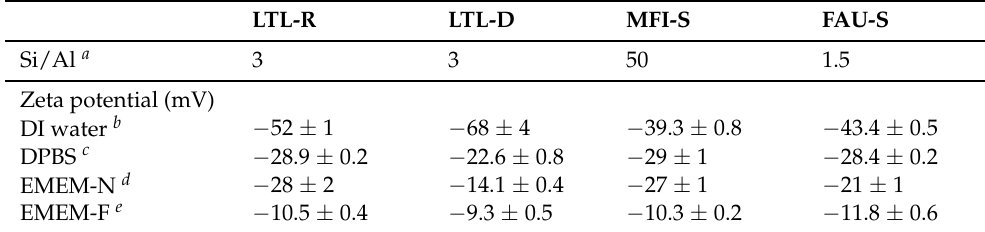
Table 1. Physicochemical properties of zeolite particles.